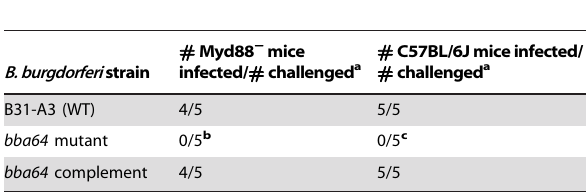
Table 3. Feeding of infected nymphs on MyD88 deficient